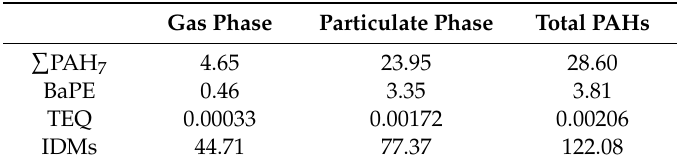
Table 4. Potential toxicity risk of